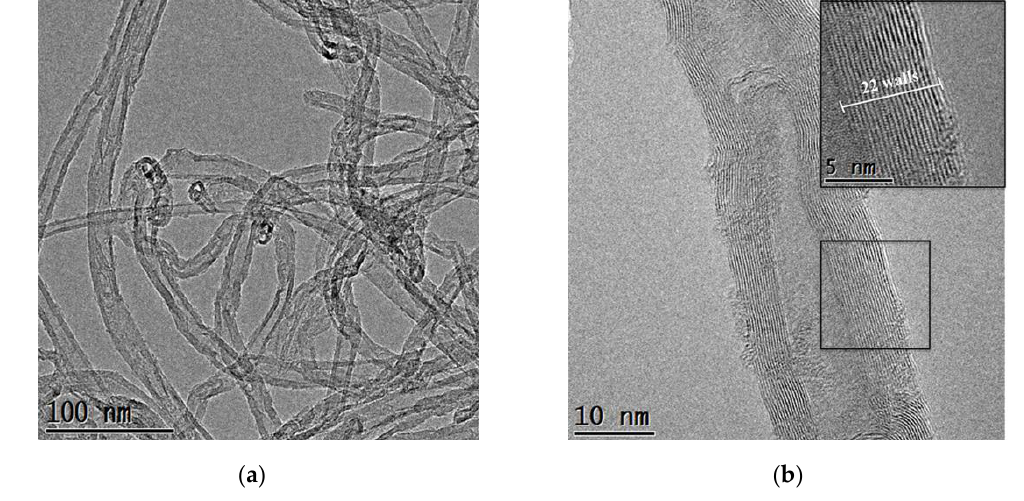
Figure 1. ( a ) TEM image of as-received carbon nanotubes (CNTs), and ( b ) high-resolution transmission electron microscopy (HRTEM) image of a CNT showing the morphology and structure of the multi-walled carbon nanotubes (MWCNTs) as well as detail showing the number of walls measured for this CNT.